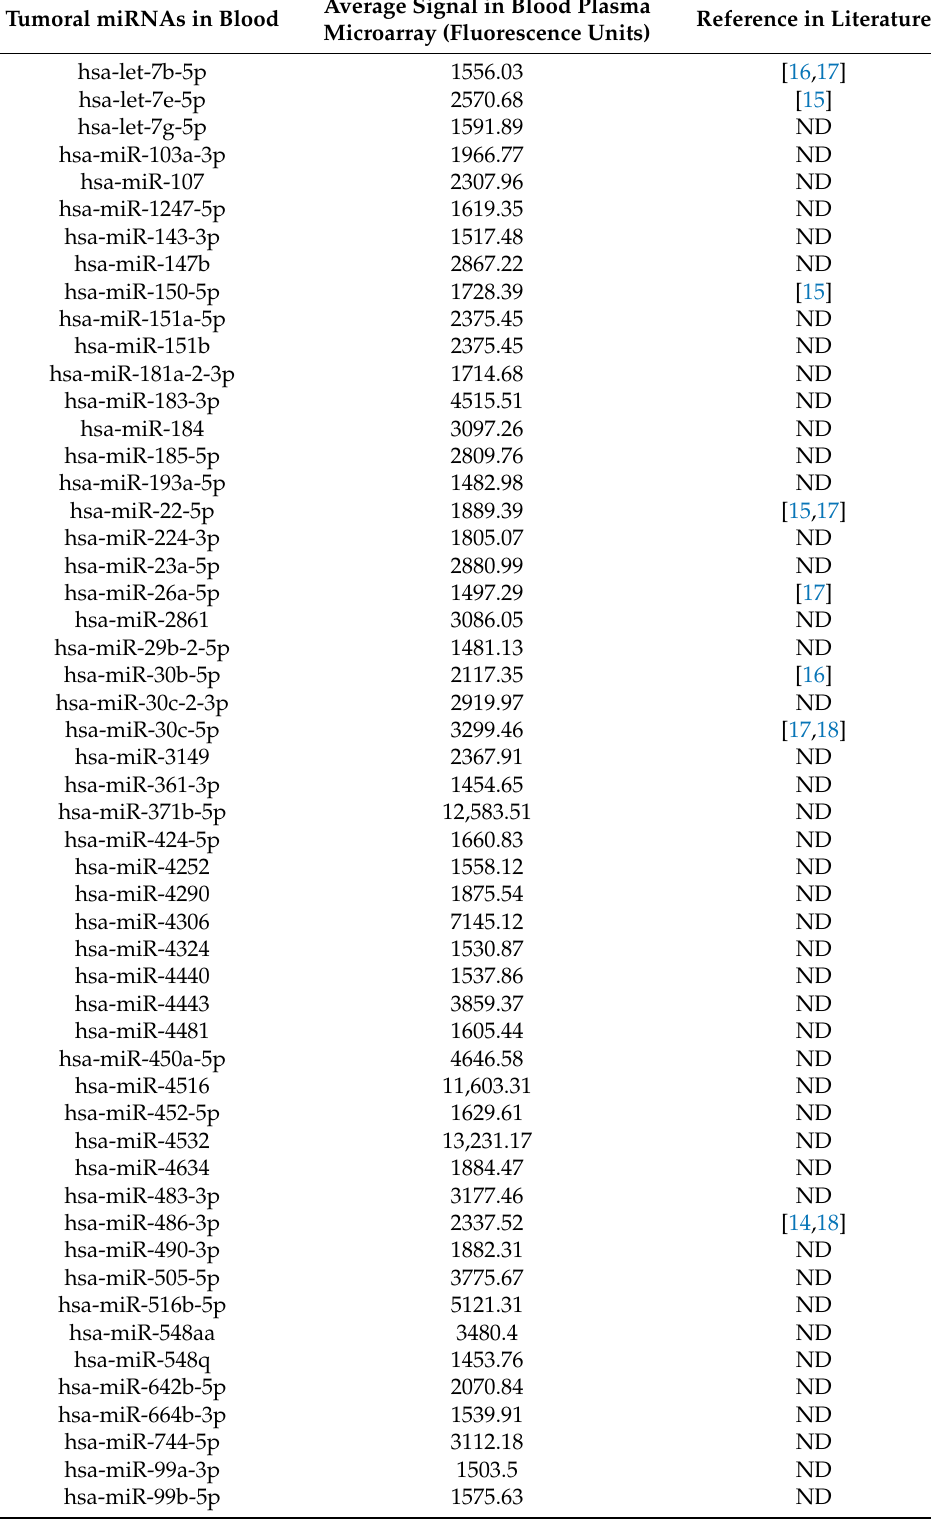
Table 3. Cancer-related miRNAs present in the blood with a high expression falling in the upper quartile of the distribution of intensity expression. The intensity of the miRNA expression was reported in fluorescence units as detected by microarray analysis (middle column). The miRNAs found in our study were compared with the bibliography to evaluate if their dysregulation in the blood could be considered as potential markers for lung cancer (right